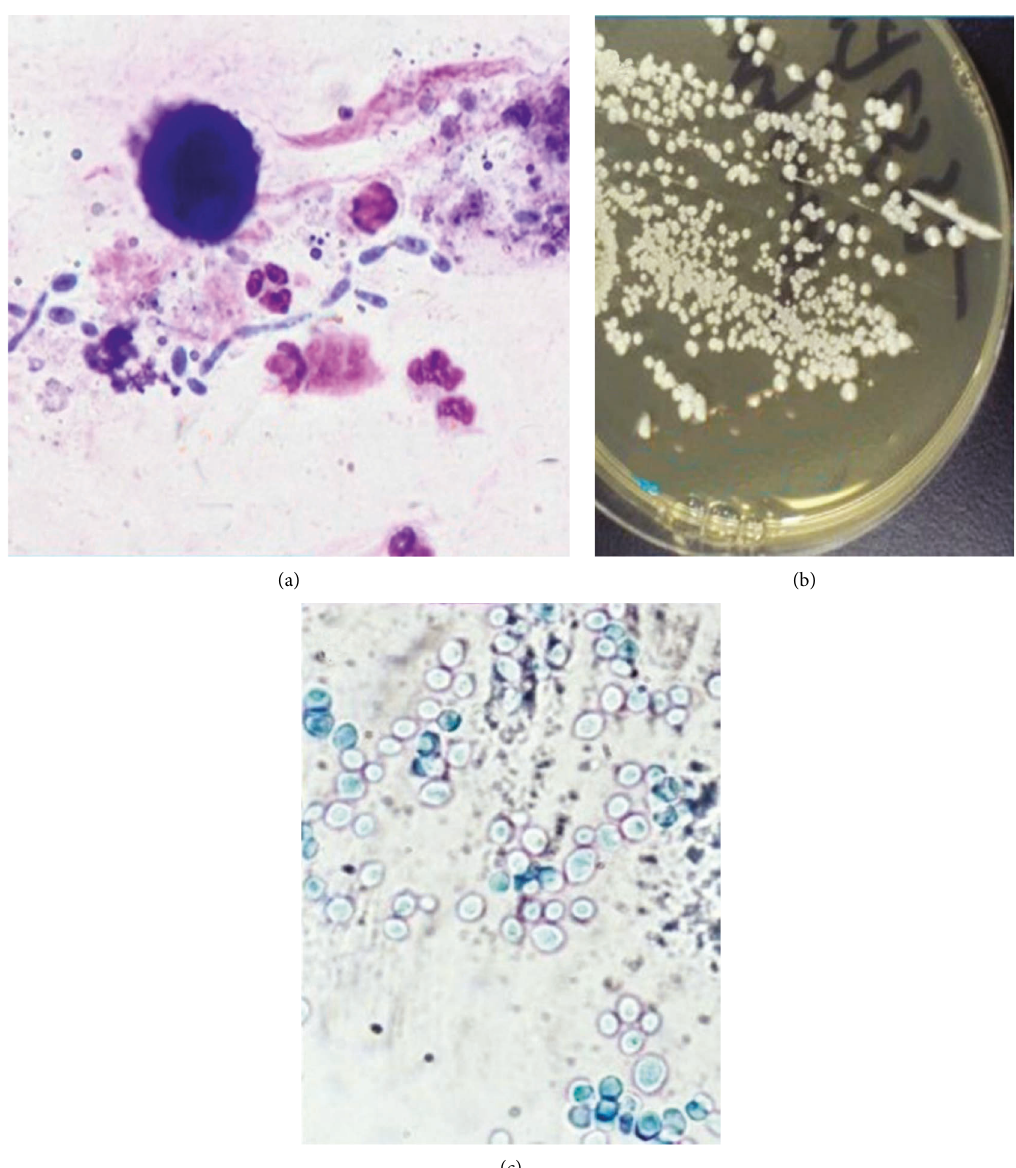
Figure 3: Demonstration of yeast in a direct smear made from sputum; note the presence of pseudohyphae and budding yeast cells (a). Growth of yeasts from sputum sample (strain mat532y) on SDA medium (b) and an indirect smear displaying yeast cells (LPCB × 100)